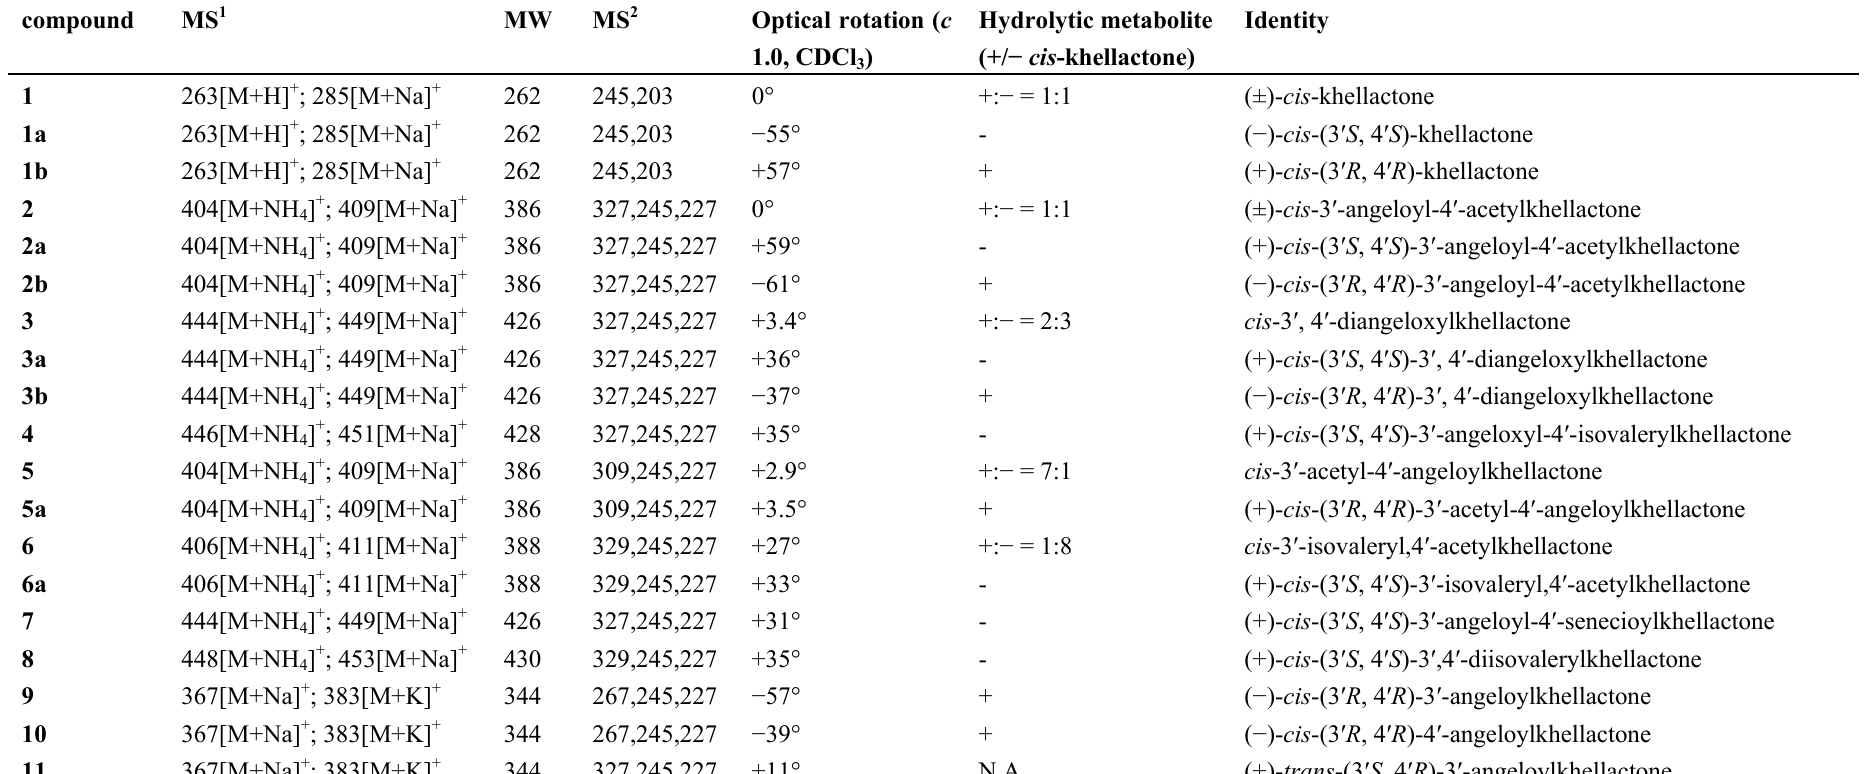
Table 1. HPLC-MS/MS data and optical rotations of pyranocoumarins from Qian-hu and their hydrolytic